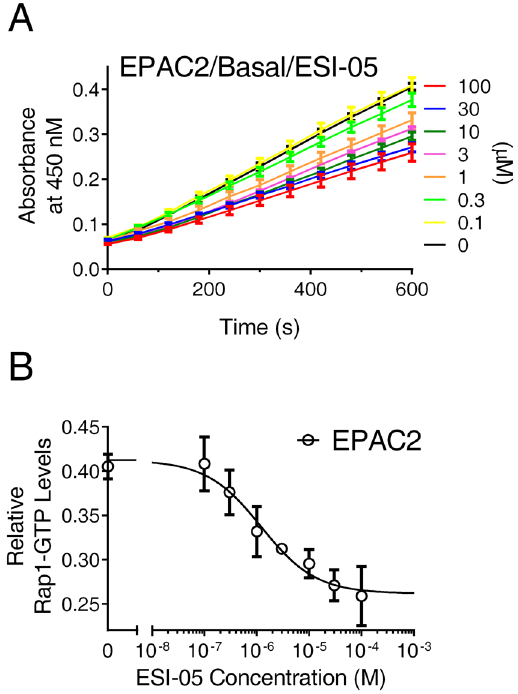
Figure 7. Dose-dependent inhibition of basal EPAC2 activation by ESI-05. ( A ) Time course of EPAC2- mediated basal Rap1 activation in the presence of various concentrations of ESI-05. ( B ) Relative basal Rap1- GTP levels as a function of ESI-05 concentration in HEK293 cells overexpressing EPAC2. Data are presented as Means ± SD, n =